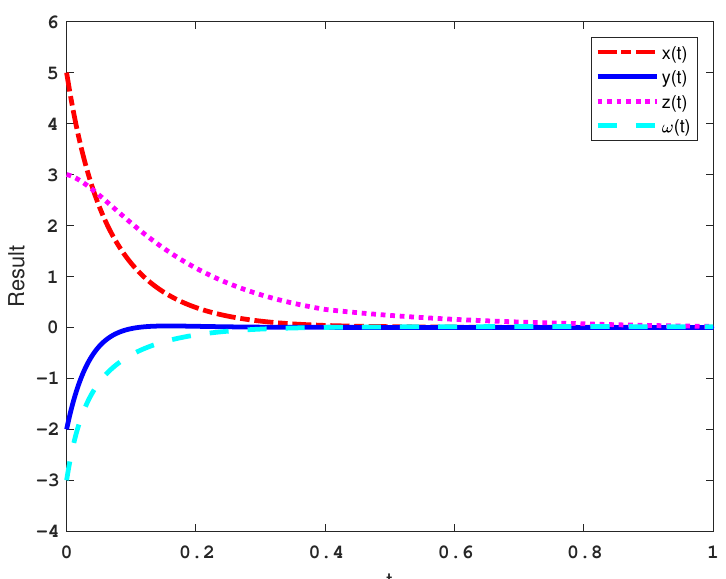
Figure 7. The time response curves of the controlled system with periodically intermittent control with variable control